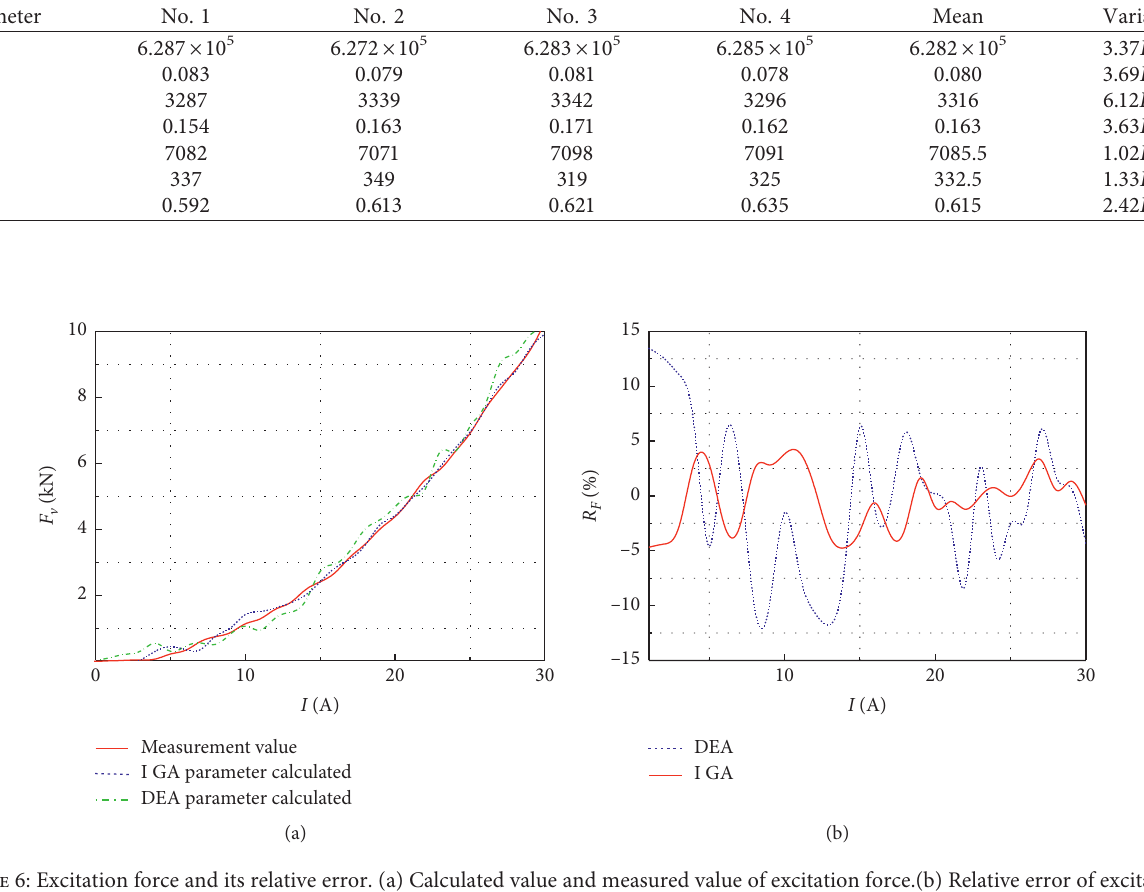
Table 4: Repeated identified data of IGA.